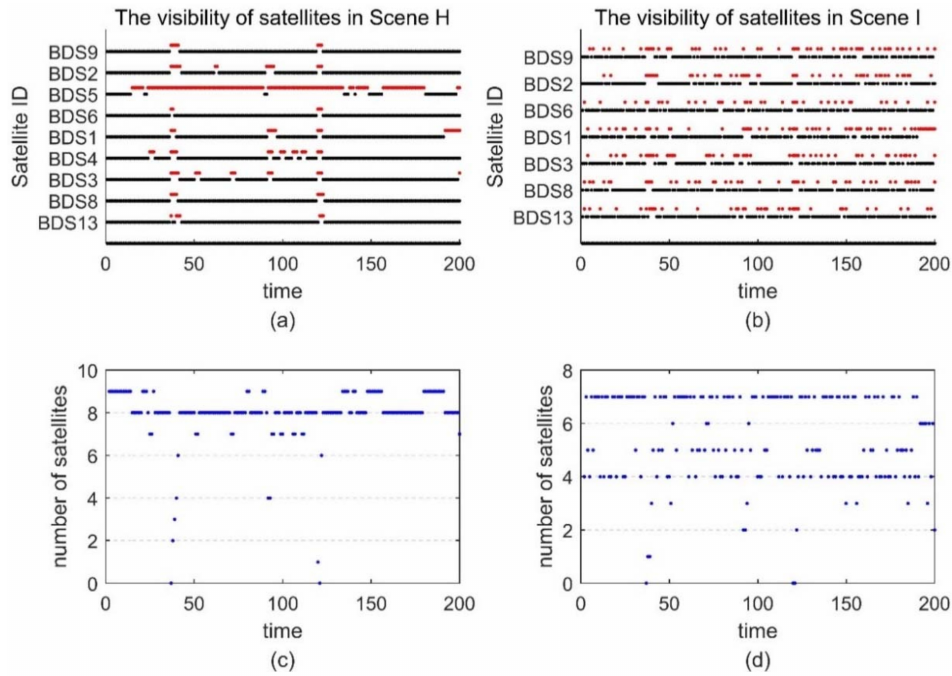
Figure 17. ( a ) The satellite visibility of the 200-s real data for Scene H; ( b ) The satellite visibility for Scene I; ( c ) The number of satellites in Scene H; ( d ) The number of satellites in Scene